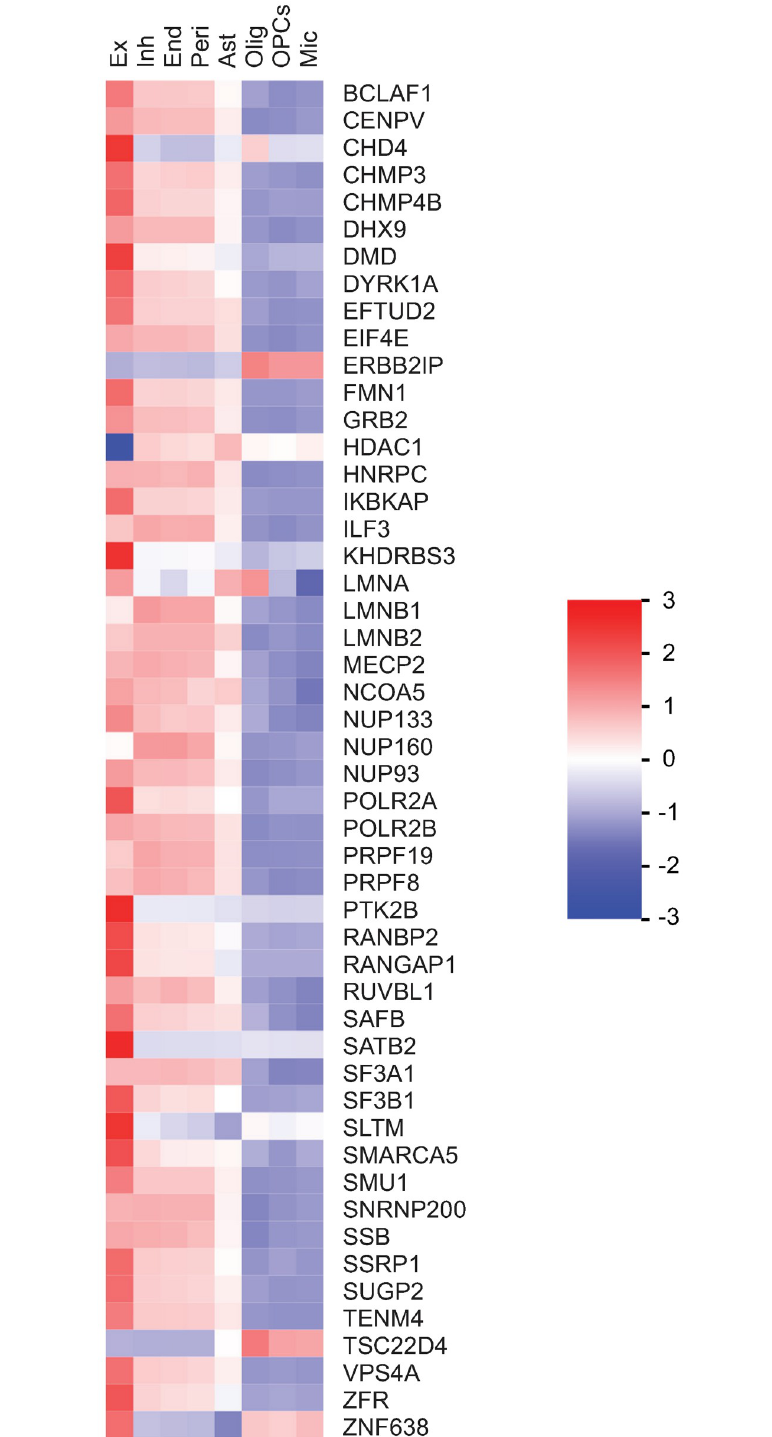
Fig 5. Expression of human orthologues of mouse SATB2 interactors across different cell types in adult human brain. Heatmap displaying the expression levels (Unique Molecular Identifier counts, [31]) of the human orthologs of mouse SATB2 interactors averaged across all cells within each cell type (4770 Excitatory neurons (Ex), 2337 Inhibitory neurons (Inh), 51 Endothelial cells (End), 45 Pericytes (Peri), 737 Astrocytes (Ast), 1758 Oligodendrocytes (Olig), 433 OPCs, 188 Microglia (Mic)). The color scale bar shows z-score values after z-score row normalization.